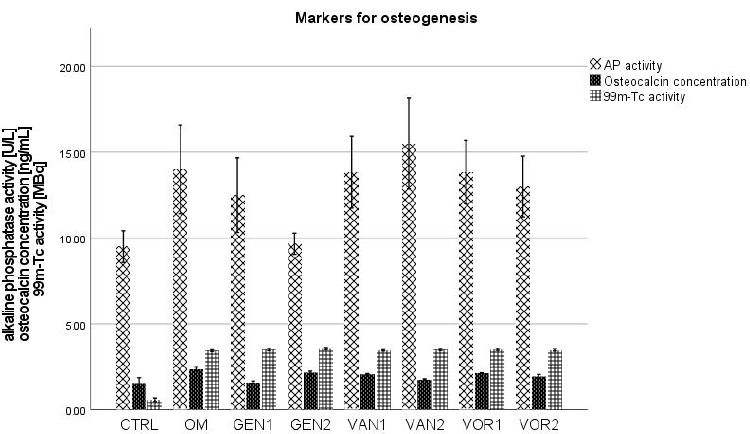
Figure 14. Mean values for the osteogenic markers AP activity, osteocalcin concentration and 99m Technetium activity per group. The error bars show the error of mean.